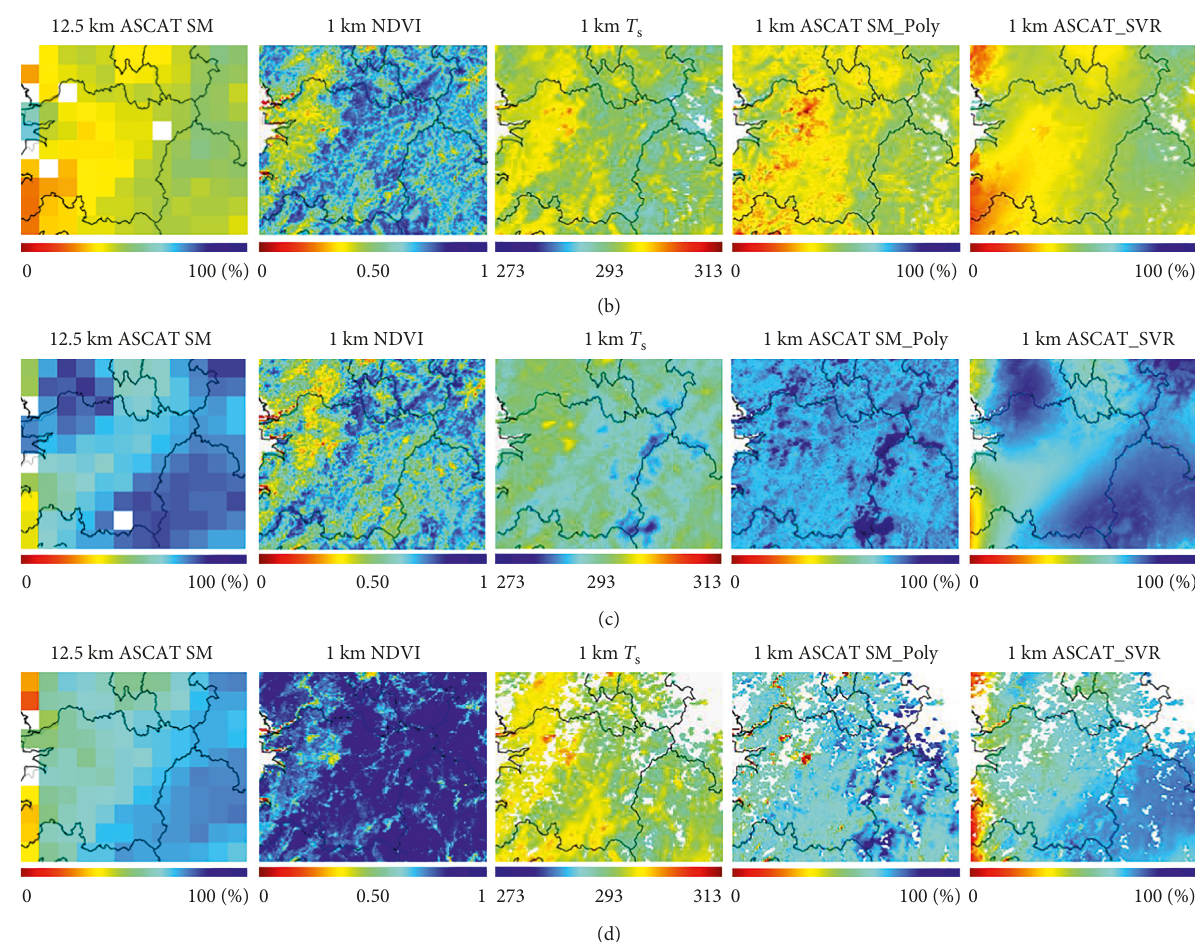
Figure 7: Spatial distributions of the original and downscaled SM, NDVI, and T April 26 and September